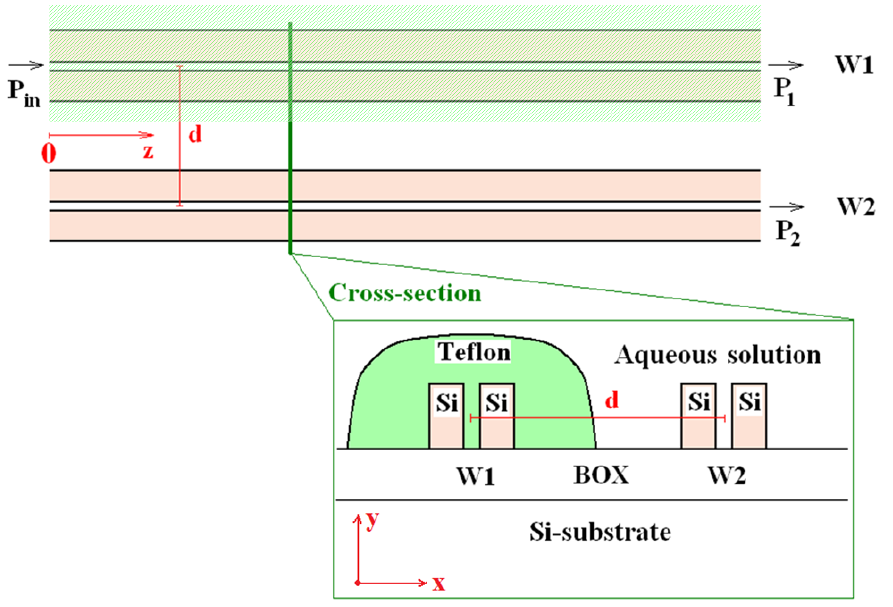
Figure 2 . Architecture of proposed integrated optical